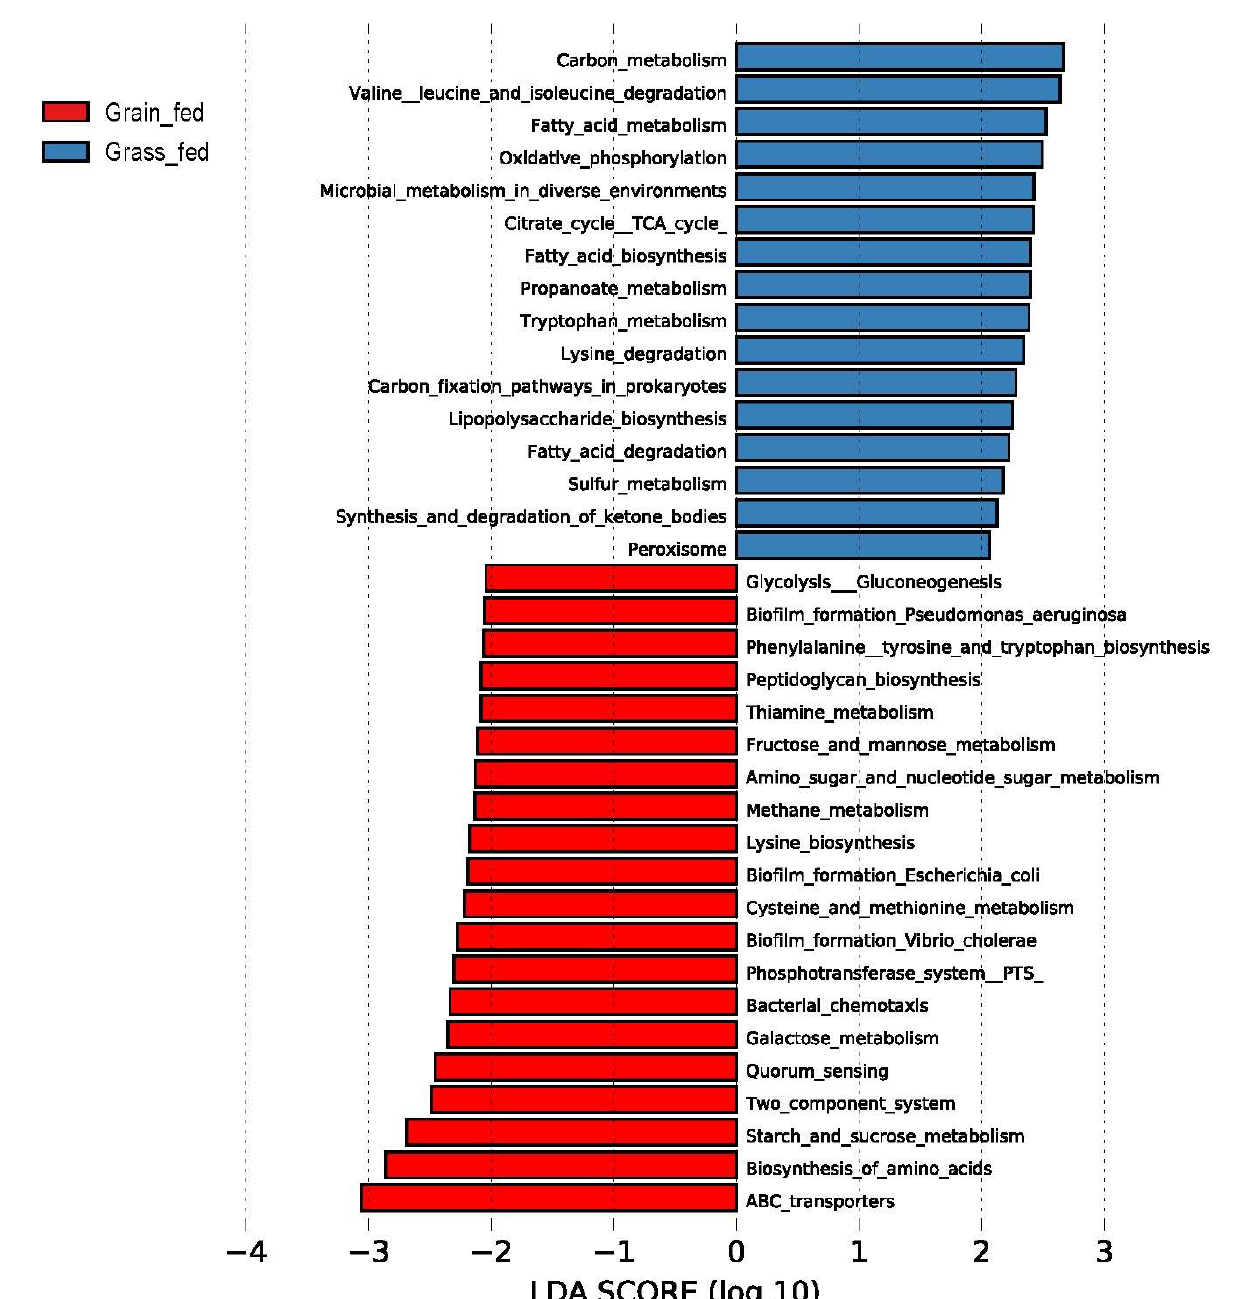
Figure 6. Predicted KEGG pathways significantly influenced by the effect of diets on rumen bacterial communities in Angus beef cattle (LDA score ≥